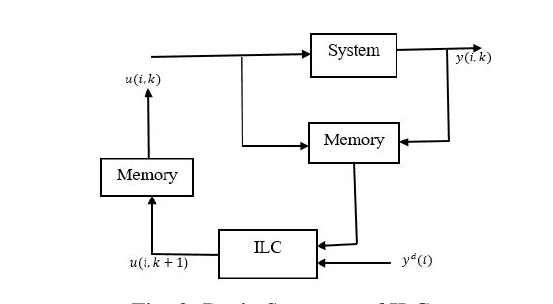
Fig. 3: Basic Structure of